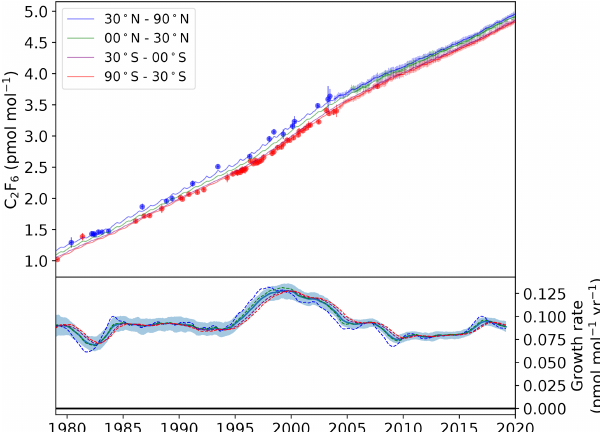
Figure 3. Modelled semi-hemispheric monthly average C 2 F 6 mole fractions (30–90 ◦ N: blue; 0–30 ◦ N: green; 30–0 ◦ S: purple; 90– 30 ◦ S: red). Monthly averaged baseline observations are shown as data points with 1 σ error bars. The more sparse filled circles rep- resent northern (blue) and southern (red) hemispheric air archive samples. The solid trend lines were calculated using the AGAGE 12-box model with emissions from the inversion as input. The lower plot shows the model-derived mole fraction growth rate, smoothed with an approximate 1-year filter, for each semi-hemisphere (dashed lines) and the global mean with 1 σ uncertainty (solid line and shad-